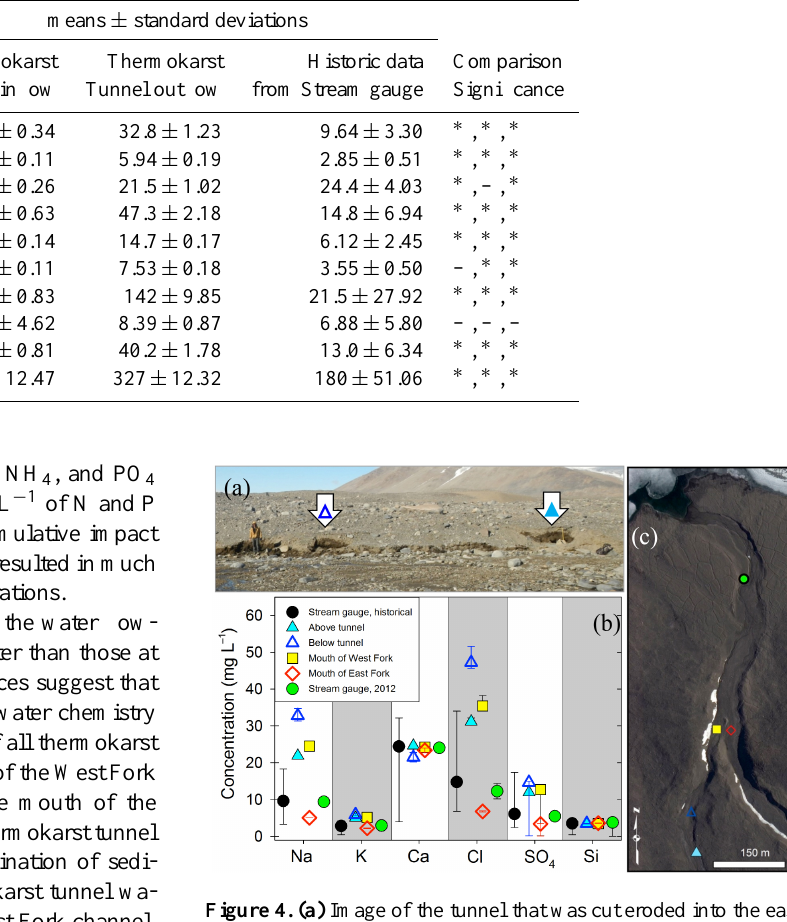
Figure 4. (a) Image of the tunnel that was cut eroded into the east- ern bank of the West Fork of Crescent Stream. Flow is from right to left in this image. The cyan (entrance) and blue (exit) arrows correspond to the cyan and blue symbols below. (b) Mean (sym- bols) and ranges of concentrations of major ions of historical data collected over 15years at the stream gauge ( n = 47, except for Si, in which case, n = 46; downstream-most location), at the stream gauge in 2012 (i.e., after permafrost degradation in banks; n = 2), stream water just above a 20m thermokarst tunnel ( n = 5), stream water just below a 20m thermokarst tunnel ( n = 5), in the West Fork ( n = 6) and in the East Fork ( n = 2), just above the location where the West and East Forks mix. (c) Locations of sampling points along Crescent